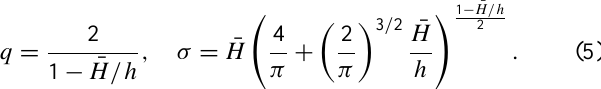
Fig. 7. Averaged distribution of run-up heights within the wave wake of a) “Star”, b) “SuperStar” and c) “Viking XPRS”; red dashed line corresponds to the Rayleigh distribution with corresponding parameters  a) 0.38 m, b) 0.40 m, c) 0.33 m; black solid line corresponds to the Weibull distribution with corresponding parameters (  , q ) a) (0.56 m, 2.75), b) (0.59 m, 2.93), c) (0.49 m, 2.70) fitted using the maximum likelihood estimate.